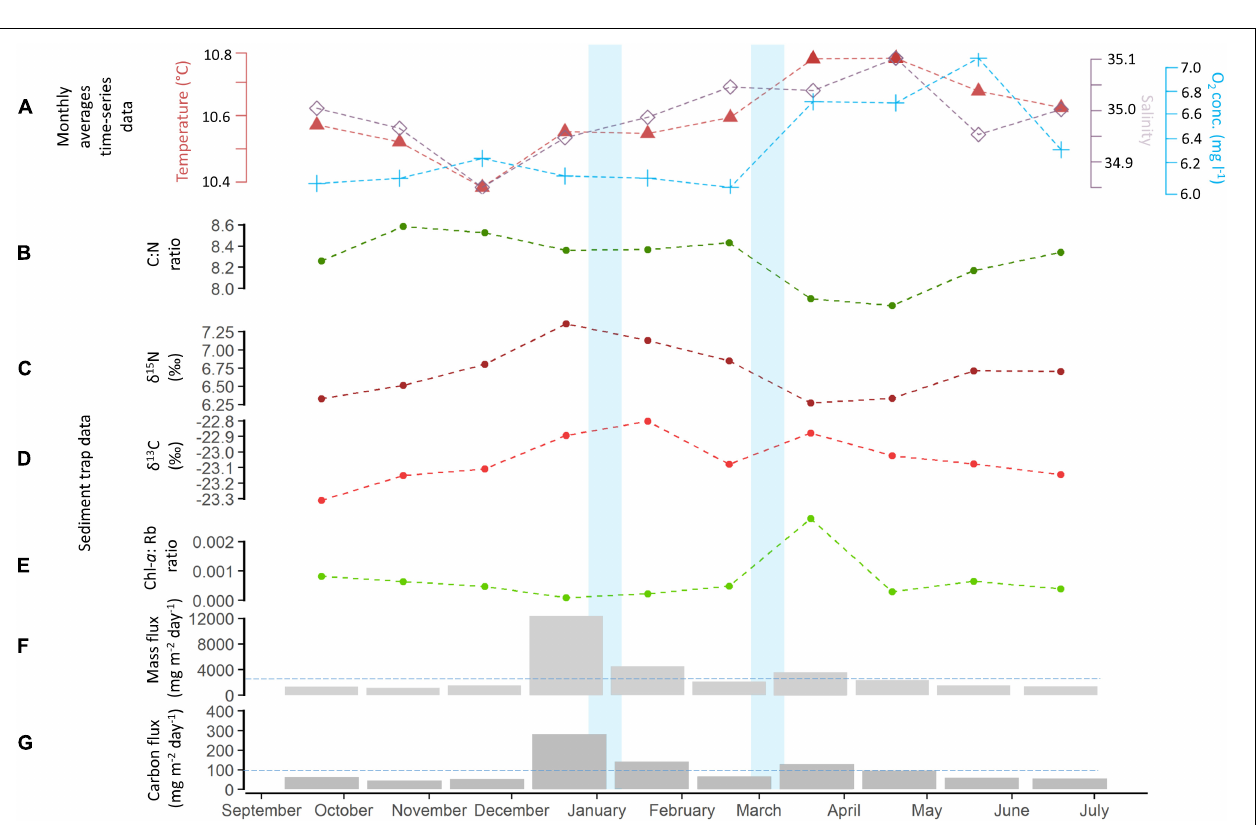
FIGURE 6 | (A) Monthly averages of temperature, salinity and oxygen concentration recorded by the lander, Sediment trap data: (B) C:N ratio; (C) δ 15 N; (D) δ 13 C; (E) Chlorophyll-a: Phaeopigments ratio of the sediment trap material; (F) Mass and (G) Carbon flux recorded by the sediment trap. Blue horizontal lines are indicating the average mass and carbon flux. Line charts and histograms represent the average value during the 30 day sediment trap interval. Storm events are highlighted in light blue.